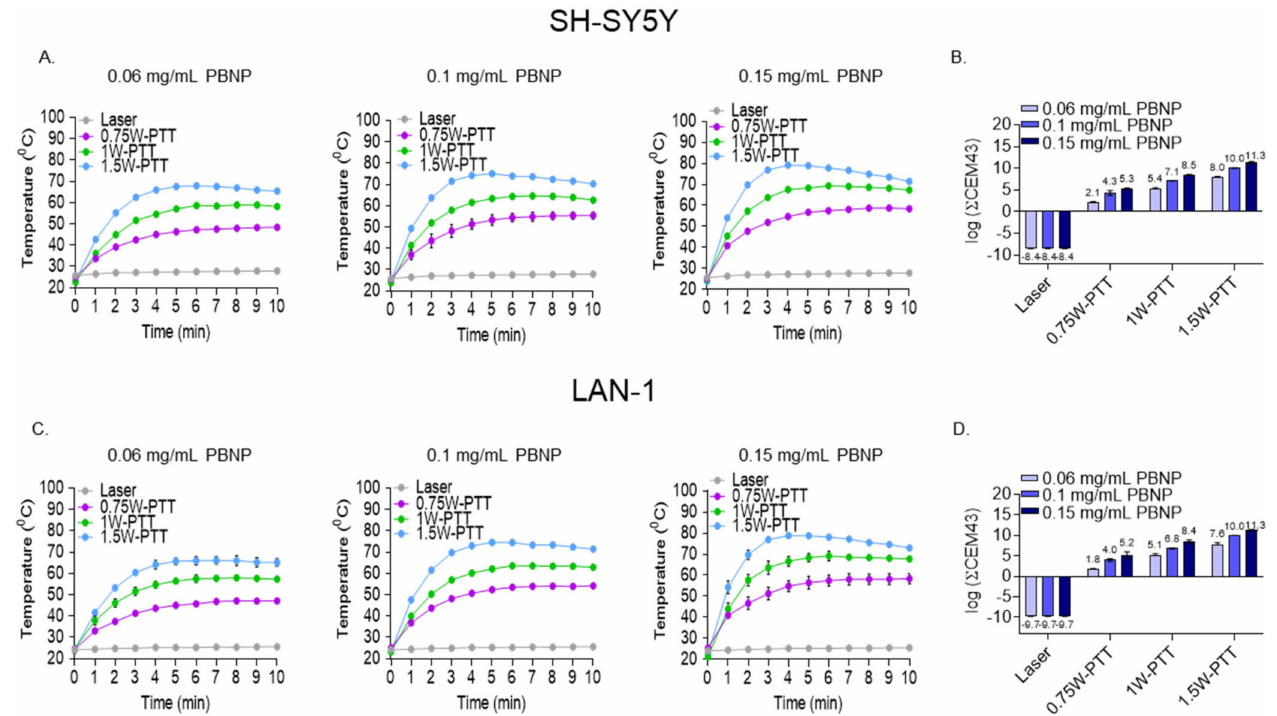
Figure 2. PBNP-PTT-administered thermal dose is controlled by PBNP concentration and laser power. Three million ( A , B ) SH-SY5Y or ( C , D ) LAN-1 human neuroblastoma cells were exposed to 0.75, 1, and 1.5 W laser power in combination with 0 (Laser), 0.06, 0.1, or 0.15 mg/mL PBNPs. ( A , C ) Time- temperature graphs represents the cell temperatures recorded for each condition at 1 min intervals for a total of 10 min. ( B , D ) Thermal doses applied to cells were calculated from the time-temperature curves for each